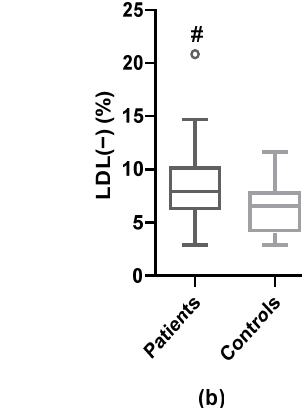
Figure 3. Concentration of oxLDL and LDL( − ) according to stenosis degree. Serum oxLDL levels were measured by ELISA and plasma LDL( − ) proportion was quantified by anion-exchange chromatography. ( a ) Levels of oxLDL when the patients were divided into groups of >50% stenosis and <50% stenosis. ( b ) Proportion of LDL( − ) stratifying by degree of carotid stenosis ( w / o stenosis n = 27, <50% n = 27, 50– 69% n = 13, 70–90% n = 12, >90% n = 10), Kruskal–Wallis test was performed ( p = 0.0017), # vs. controls (w/o stenosis); * vs. <50% patients; p < 0.05. 3.5. Association of Plaque Characteristics with Modified LDL Besides stenosis degree, we aimed to study the association between the proportion of LDL( − ) and other features of plaque vulnerability, including echolucency, intraplaque neovascularization, and inflammation assessed by 18 F-FDG PET/CT. Table 2 shows the levels of LDL( − ), oxLDL, and LDLc by those characteristics.